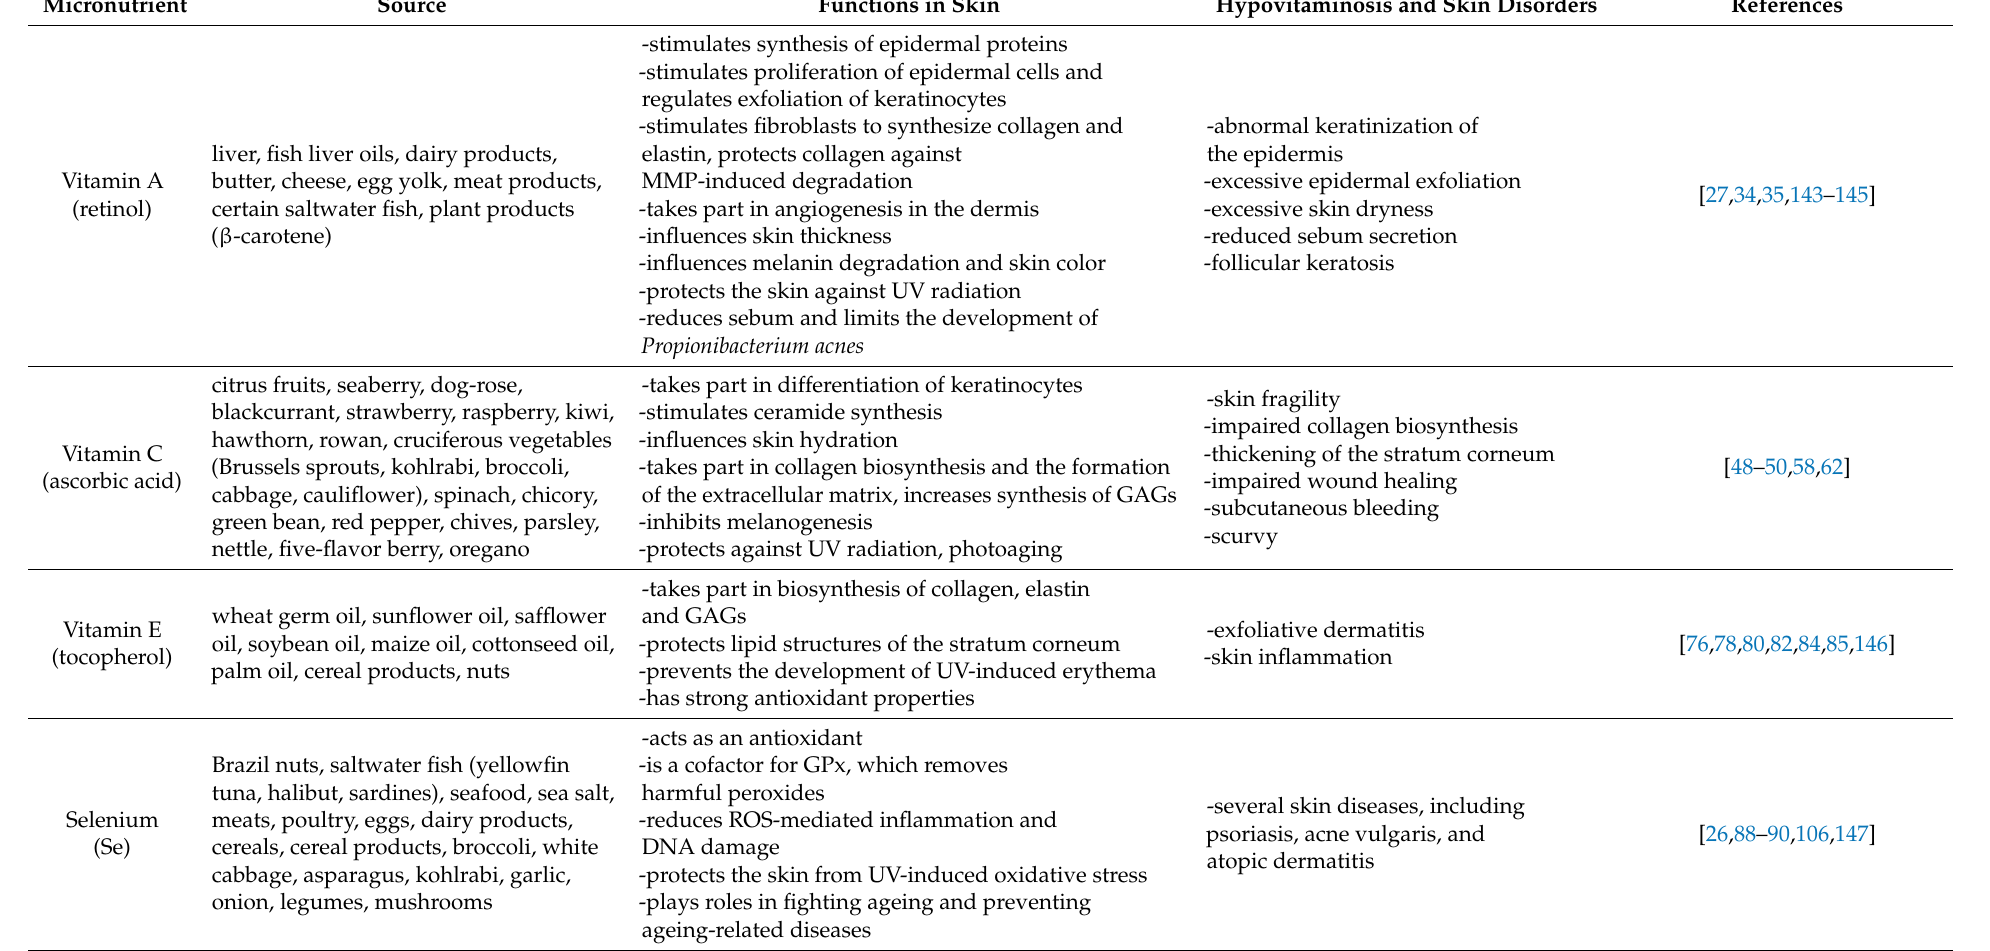
Table 1. Sources and roles of vitamins and minerals of importance for skin health and